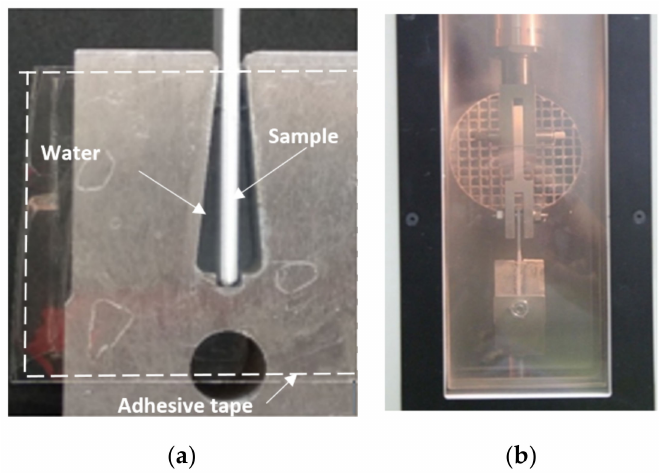
Figure 6. ( a ) Test block employed to form ice on both sides of the sample. ( b ) Block attached to the